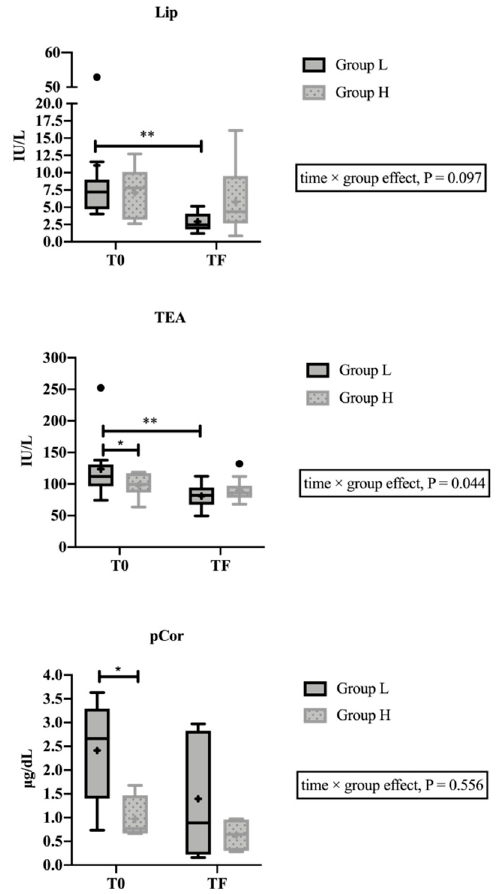
Figure 1. Results of lipase (Lip) and total esterase (TEA) in saliva, and cortisol (pCor) in plasma from a population of 22 cows divided into two groups, with lameness diagnosis (Group L, n = 11) and healthy cows (Group H, n = 11), sampled the day of diagnosis in group L or one day later in group H (T0), and twenty days after T0, when resolved their lameness lesions in group L or one day later in group H (TF). The plot shows median (line within box), 25th–75th percentiles (box), 5th and 95th percentiles (whiskers), and outliers ( • ). The cross inside the box shows the mean. Asterisk indicates statistically significant differences (Sidak’s multiple comparisons test) between times or groups (*: p < 0.05; **: p < 0.01).